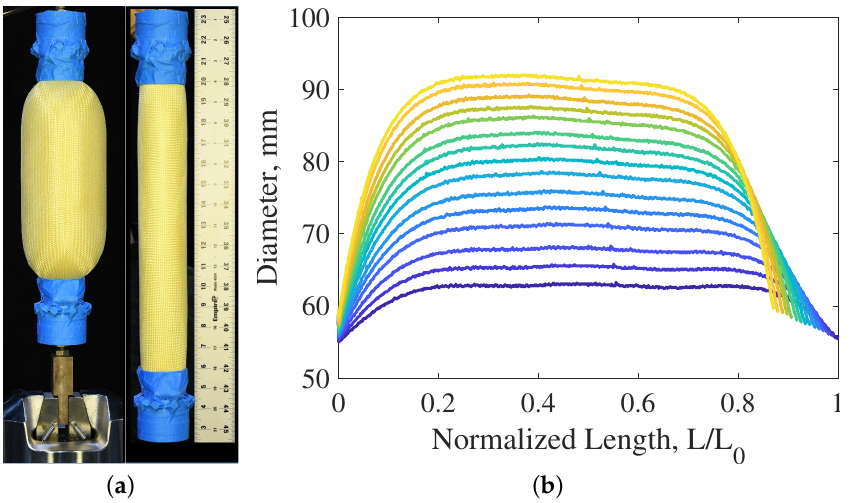
Figure 18. Characterization of the 57.2 mm diameter PAM at 179 kPa (26 psi): ( a ) Free contraction and resting length states. ( b ) Evolution of the PAMs shape